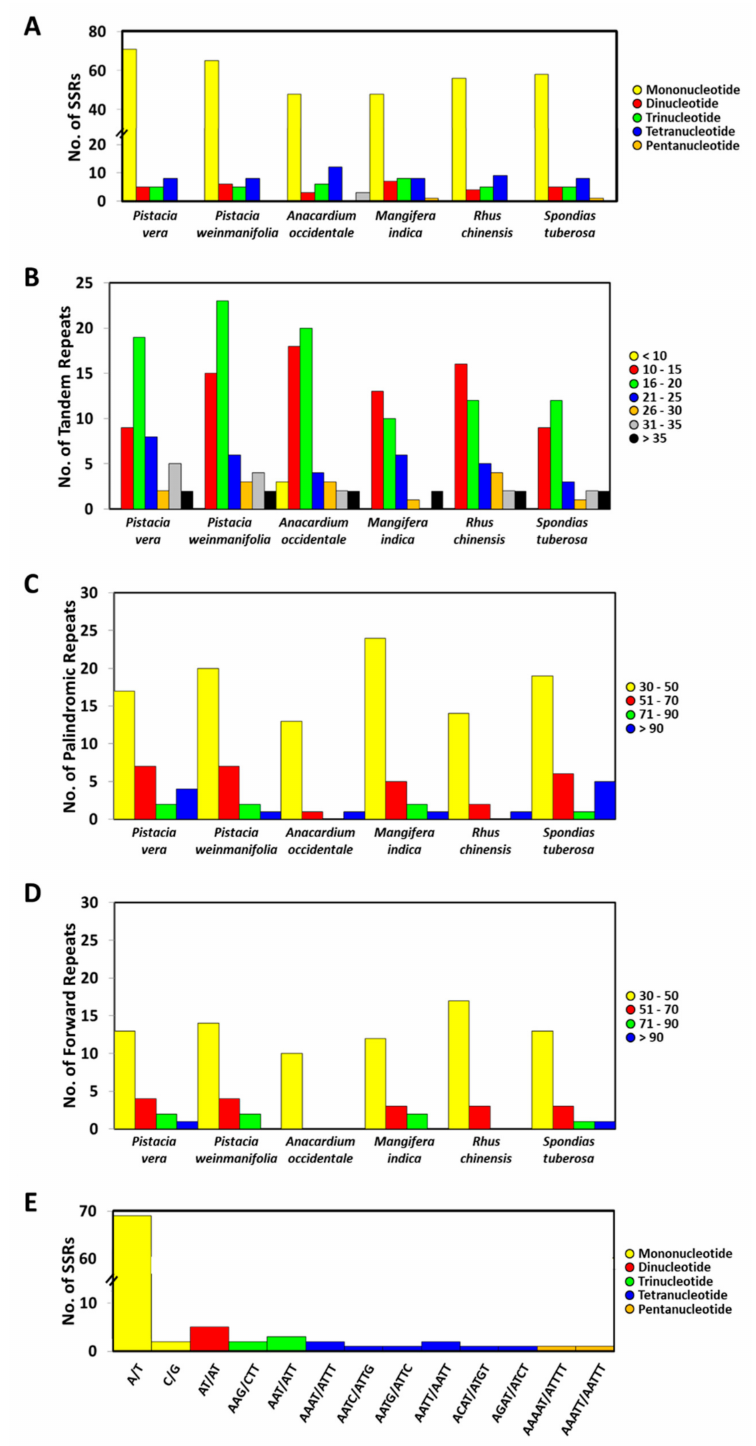
Figure 2. Statistics describing SSR ( A ) motif type and frequency, ( B ) number of tandem repeats, ( C ) number of palindromic repeats, ( D ) and number of forward repeats in the chloroplast genomes of different Anacardiaceae family members. ( E ) SSR repeat frequency within the P. vera chloro- plast